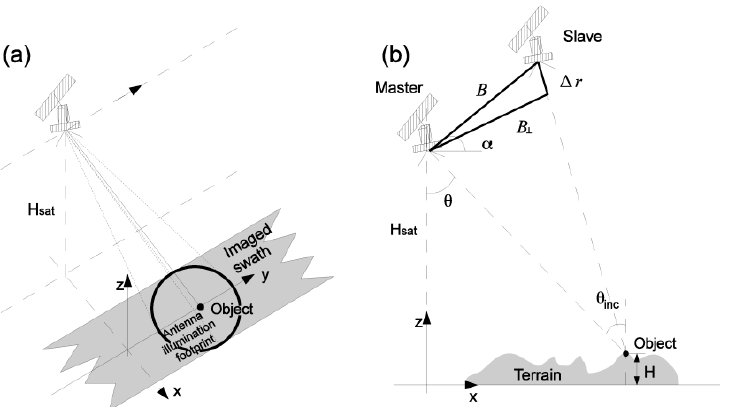
Figure 5. ( a ) SAR and ( b ) repeat-pass InSAR imaging geometry, adapted from [29]. ( a ) The satellite at height H sat moves along the azimuth direction for y axis and the direction of the main lobe of microwave pulse is nominated as the range direction for x axis. The area circled by black indicates the footprint of a single pulse. ( b ) Two SAR sensors, master and slave are at a distance by a baseline B . The perpendicular baseline B ⊥ is defined by the effective distance between master and slave sensors, measured perpendicular to the look direction. The angle between (cid:1828) and horizontal plane is defined as (cid:2009) . The look angle (cid:2016) is the angle with which the radar looks at the surface. The incidence angle (cid:2016) (cid:3036)(cid:3041)(cid:3030) is defined with regard to the ellipsoid. The height of the object is (cid:1834) with regard to a reference surface.